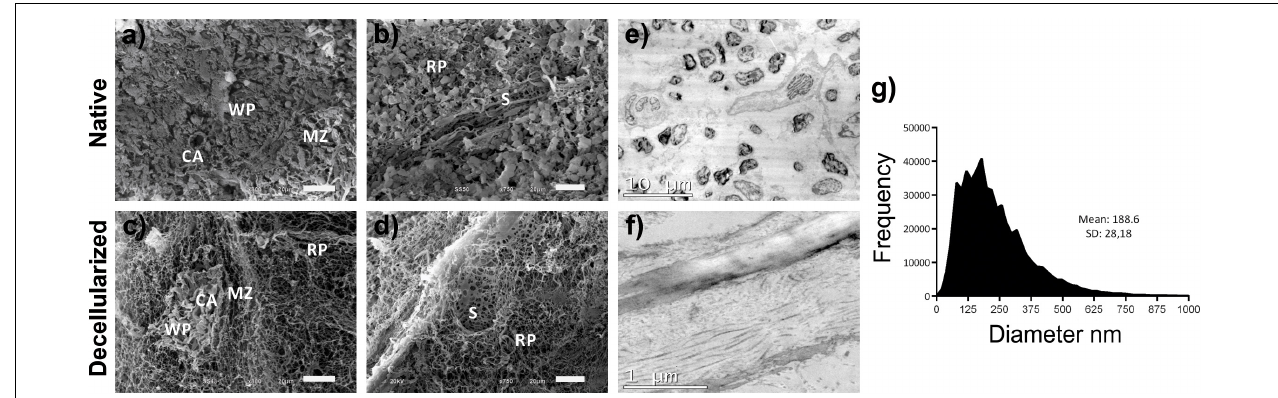
FIGURE 3 | Ultrastructural analysis of the splenic scaffold. (a–d) Representative scanning electron micrographs showing the removal of all cells and their debris with the maintenance of the main components of the splenic parenchyma as in native tissue after decellularization of the scaffold. (e,f) Representative images of ultrastructural analysis by TEM demonstrating the absence of cells in the scaffold, unlike the native organ, in addition to the maintenance of the main components of the ECM, mainly collagen fibers. (g) Quantitative analysis of the fibers in the matrix of decellularized scaffolds showing their diversity of diameters ( n = 3). Scale bars: (a–d) : 20 µ m; (e) : 10 µ m; (f) : 1 µ m. WP, white pulp; RP, red pulp; marginal zone; CA, central artery of the white pulp; S, red pulp